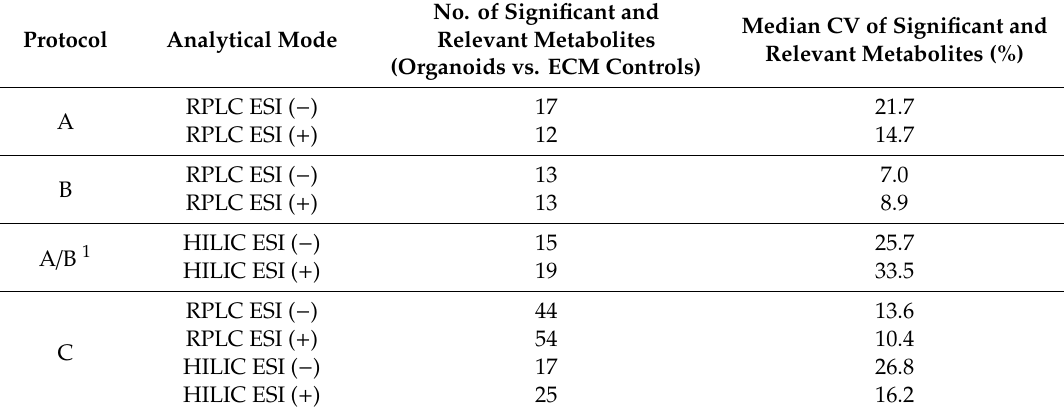
Table 1. Number of metabolites with significantly and relevantly higher abundance in organoid samples compared to respective controls (ECM only) following di ff erent sample preparation protocols and LC QTOF-MS methods in the indicated electrospray ionization (ESI)